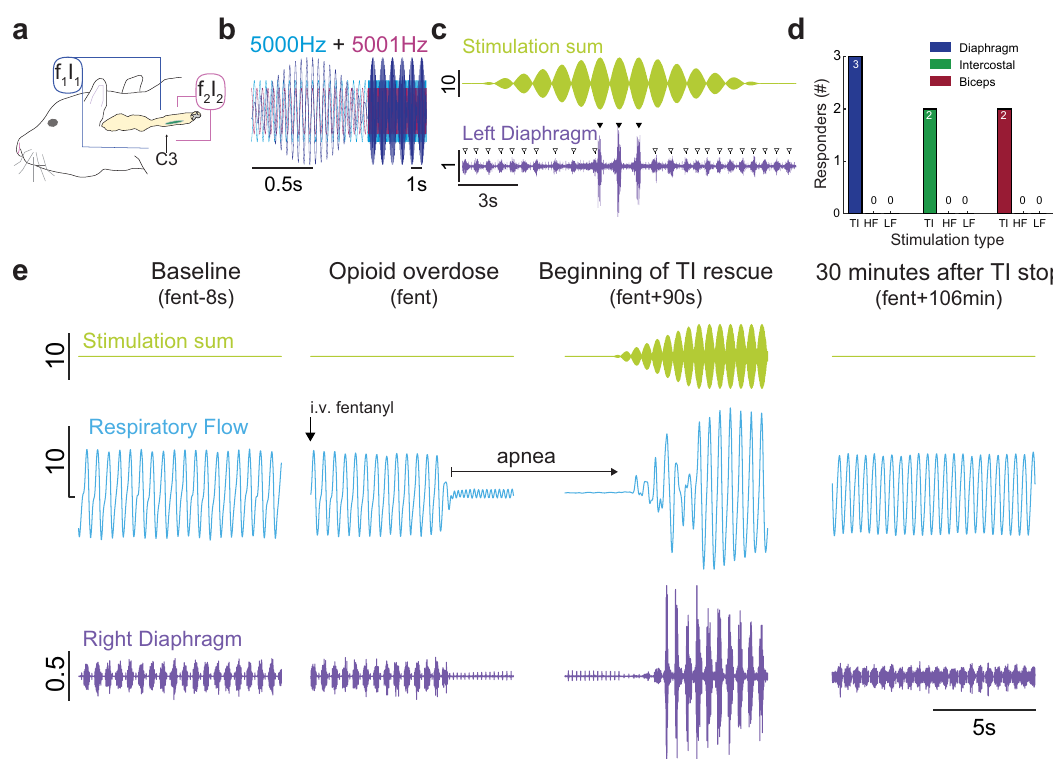
Fig. 1 Representative traces show that intramuscular TI stimulation restores diaphragm EMG activity and inspiratory air fl ow after opioid overdose. a Schematic of wire placement targeting C3 to activate the phrenic motor pool (green column). Stimulation was delivered via a pair of wires on each side of the neck. One wire per side was inserted into the neck musculature with intent to target the ventral and dorsal aspect of the spinal column near C3. The left electrode pair (blue) was stimulated with current-1 (I 1 ) and frequency-1 (f 1 ), and the right pair (pink) was stimulated with current-2 (I 2 ) and frequency-2 (f 2 ). b Stimulation paradigm. f 1 = 5000Hz (blue), f 2 = 5001 Hz (pink), produces a TI fi eld with a modulation envelope or beat frequency of 1 Hz (purple), which produced a respiratory rate of 60 breaths per minute. c TI stimulation causes robust diaphragm EMG activation in phase with the TI beat